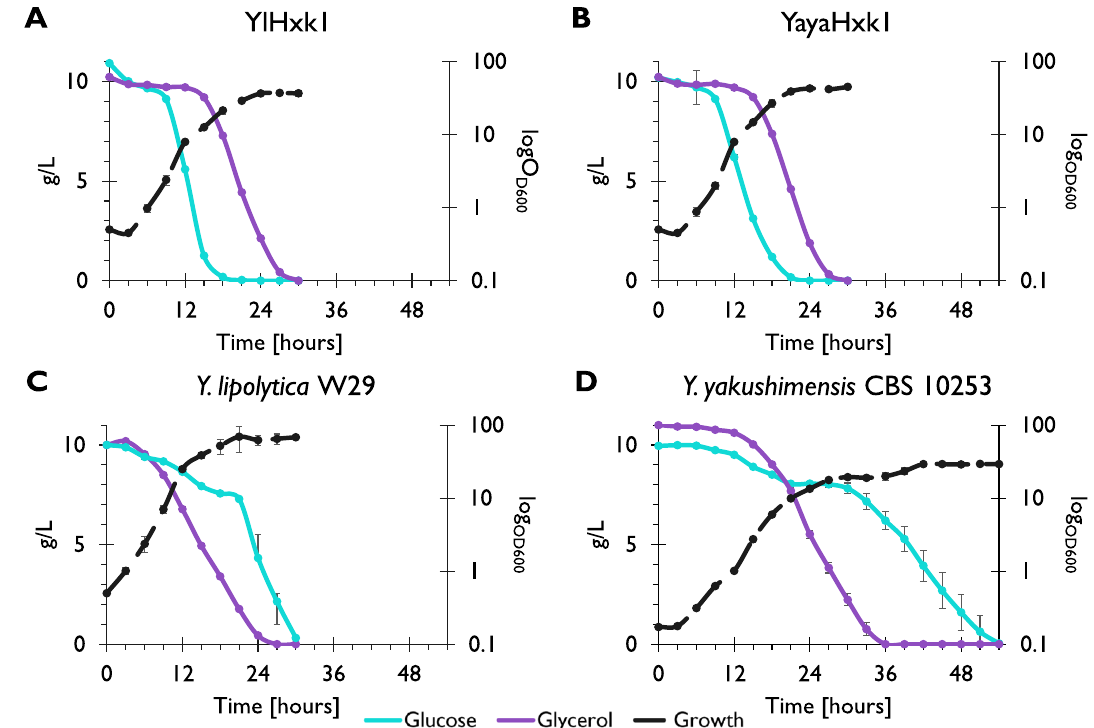
Figure 6. Growth and substrate utilization of Y. lipolytica strain expressing YlHxk1 ( A ), YayaHxk1 ( B ), a wild- type Y. lipolytica W29 strain ( C ) and a wild-type Y. yakushimensis CBS 10253 strain in YNB minimal medium with glucose and